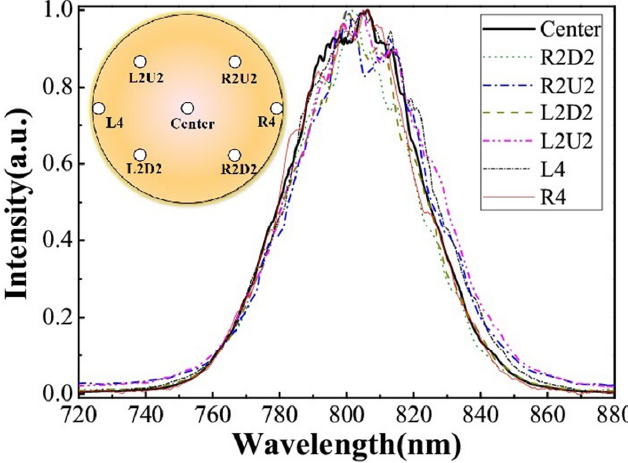
Figure 12. TG signal spectra at seven different points on the beam, shown in the inset. L: left; R: right; U: up; D: down; the number corresponds to the distance from the center point, e.g., L2U2 is 2 mm left and 2 mm up from the center point [60].